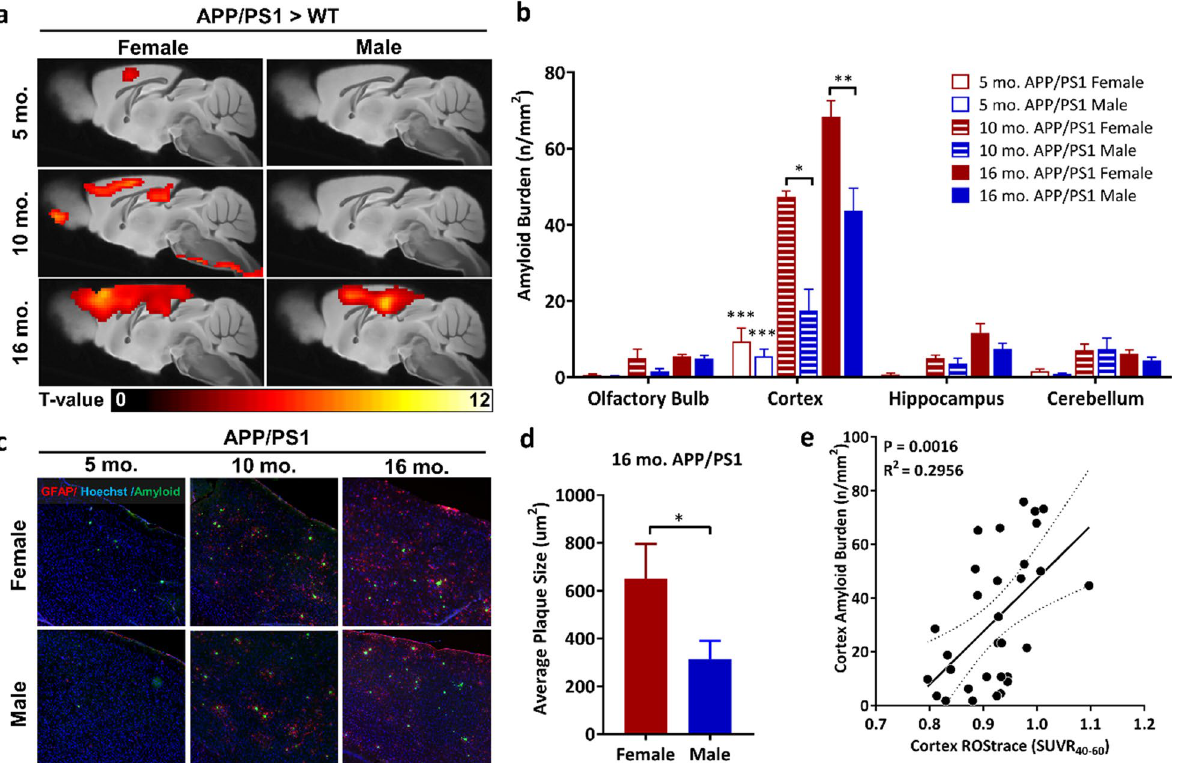
Fig. 4 Elevated [ 18 F]ROStrace retention in the APP/PS1 brain maps with spatial distribution of amyloid deposits and positively correlates with increased amyloid burden in the cortex of aging APP/PS1 mouse brain. a Statistical parametric mapping (SPM) analysis showing significant differences (uncorrected p < 0.005 and an extent cluster threshold 50) in [ 18 F]ROStrace retention per sex in 5 mo. (top row), 10 mo. (middle row), = and 16 mo. (bottom row) APP/PS1 mice versus WT. b Quantification of amyloid burden in 4 different brain regions of the APP/PS1 female (red) and male (blue) mouse brain. 5 mo. old APP/PS1 group: n 9 for male, n 5 for female, 10 mo. old APP/PS1 group: n 4 per gender. 16 mo. old APP/ = = = PS1 group: n 8 for male, n 5 for female. The statistical significance calculated by two‑way ANOVA. * p < 0.05, ** p < 0.005. *** p < 0.0001, relative to = = olfactory bulb, hippocampus, and cerebellum at 5‑mo.‑old APP/PS1 mouse. Values represent mean SEM. c Images of the cortex region of APP/PS1 ± mice 5–16 mo. of age stained with anti‑GFAP (red), anti‑beta amyloid 1–42 antibodies (green) and Hoechst (blue). Scale bar 150 µm. d Average = size of amyloid plaques in the cortex region of brains collected from 16‑mo.‑old APP/PS1 mice, n 8 for male, n 5 for female. The statistical = = significance of p value calculated by unpaired t test. Values represent